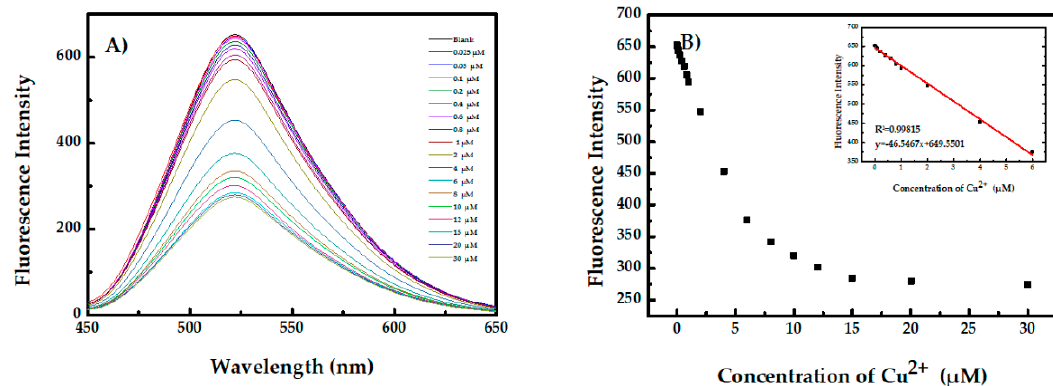
Figure 3. ( A ) Fluorescence spectra of AIE dots in the presence of different concentrations of Cu 2+ excited at 406 nm. ( B ) The plot of the fluorescence intensity ratio of AIE dots at 524 nm versus different concentrations of Cu 2+ ; the inset shows the signal change in the Cu 2+ concentration range of 0–6 μ M.